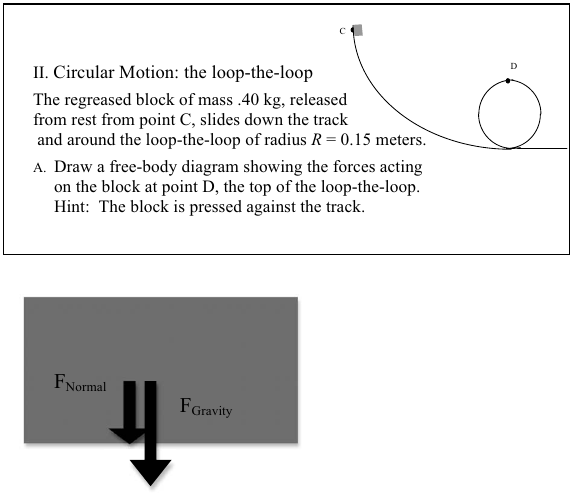
FIG. 2. An excerpt from a tutorial on energy and one possible free-body diagram of the block at